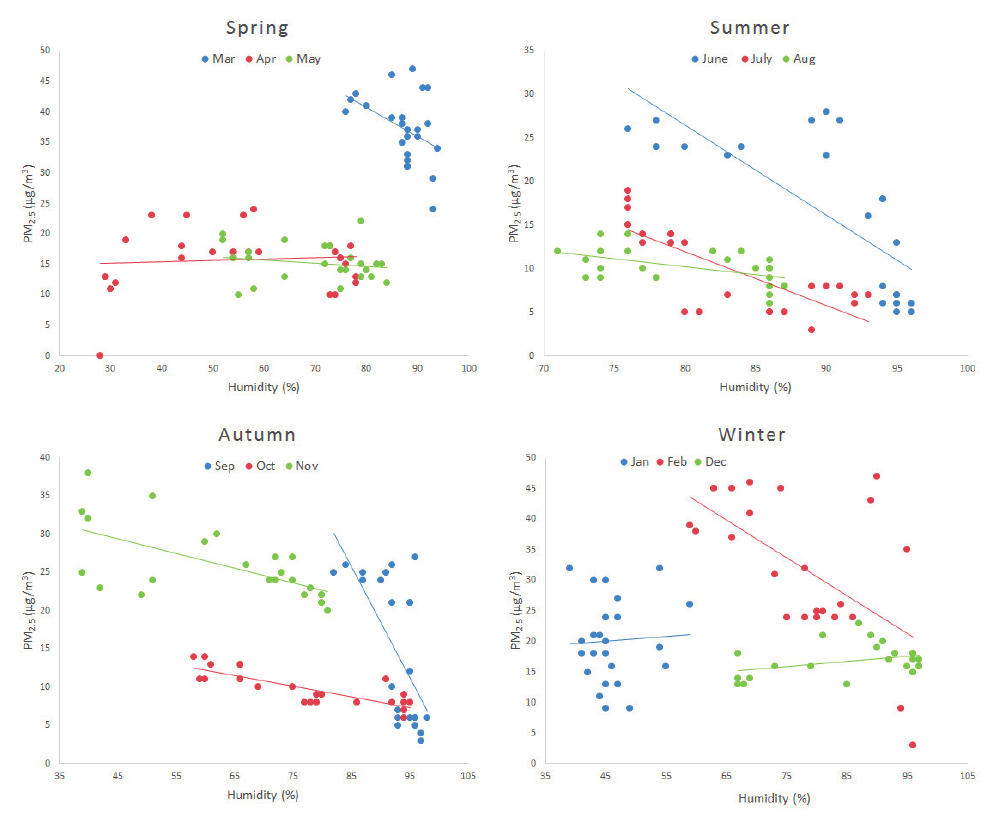
Figure 5. The relationship between PM 2.5 and humidity during the year.